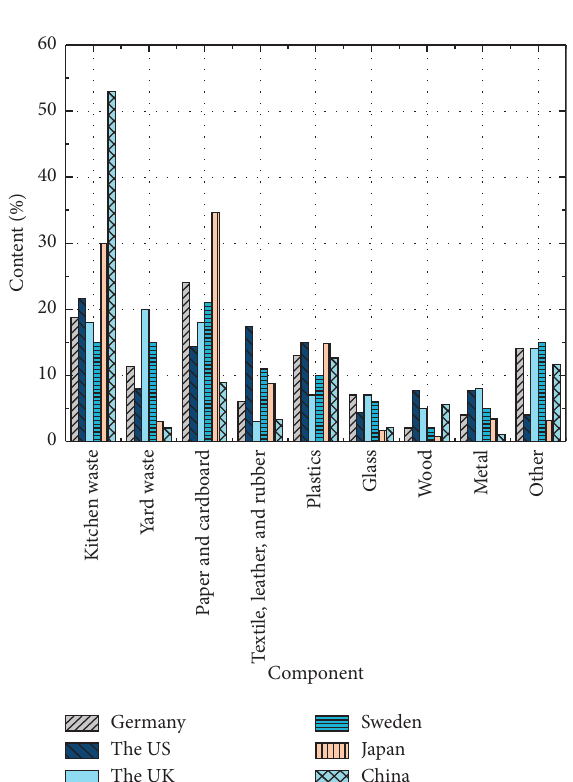
Figure 1: MSW composition in Germany, the US, the UK, Sweden, Japan, and